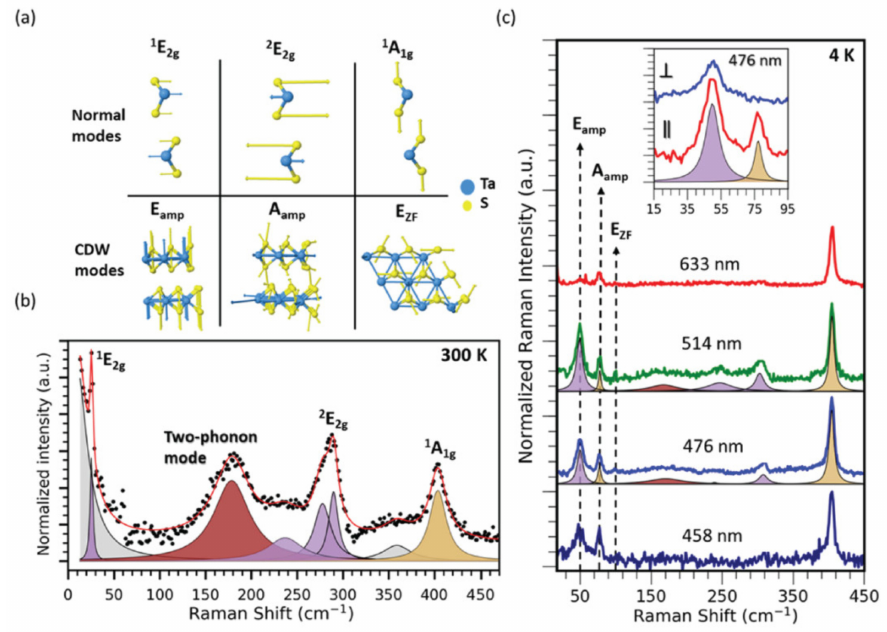
Figure 12. ( a ) Mode diagrams are shown and correspond to those seen in the normal and CDW phases. ( b ) Room-temperature Raman spectra of bulk TaS 2 reveals several modes. The two-phonon mode is shaded brown. Purple and golden shades represent modes with E and A symmetry, respectively. Gray areas represent fits to the laser Rayleigh line and other features not predicted to be part of the material’s Raman spectrum. ( c ) Excitation-dependent Raman measurements performed at 4 K with 458, 476, 514, and 633 nm laser wavelengths. Low-frequency peaks correspond to CDW amplitude modes and a zone-folded CDW mode. Reprinted figure with permission from Reference [109]. Copyright 2019 by the American Physical